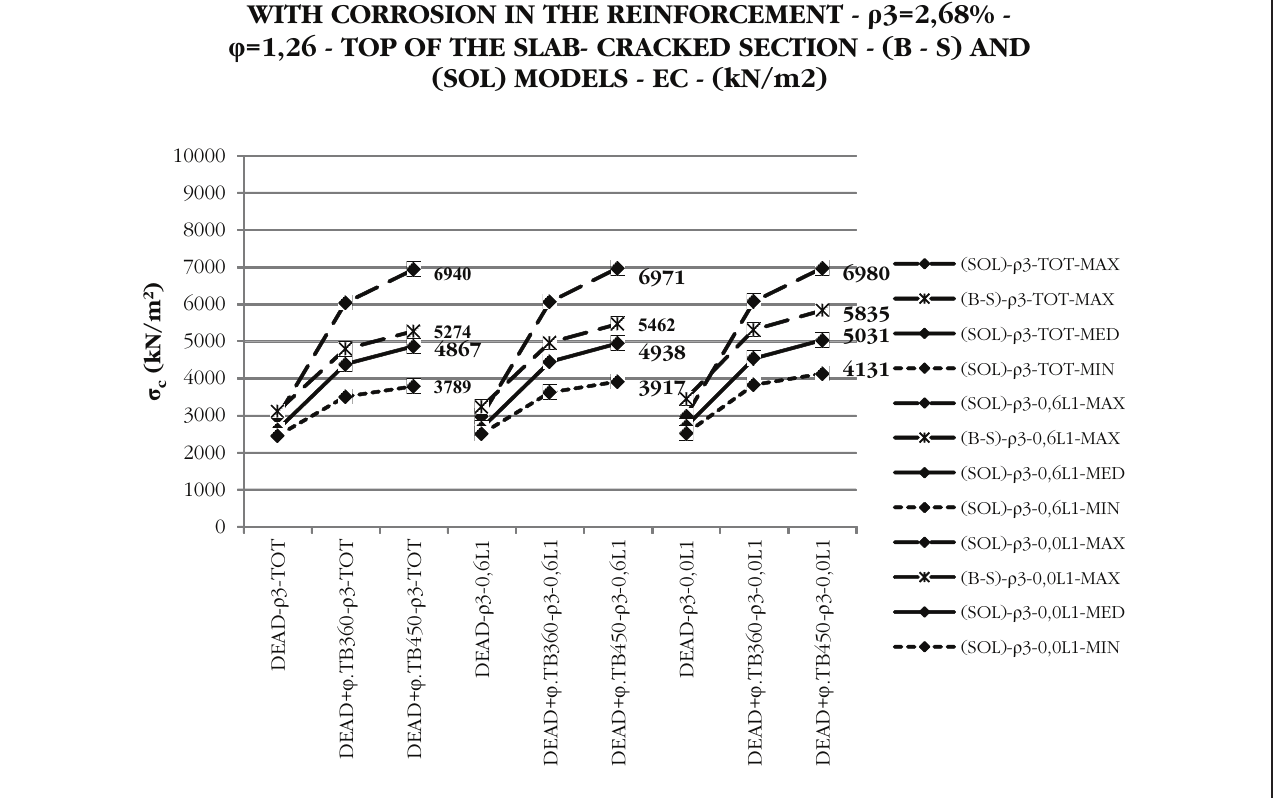
Figure 19 – Variation of minimum, medium and maximum longitudinal compressive stress in the top of the slab versus ρ for (B-S) and (SOL) models, in cracked section, modulus of elasticity E , with impact, caused by {DEAD}, {DEAD + φ .TB360} and {DEAD + φ .TB450}, with reinforced